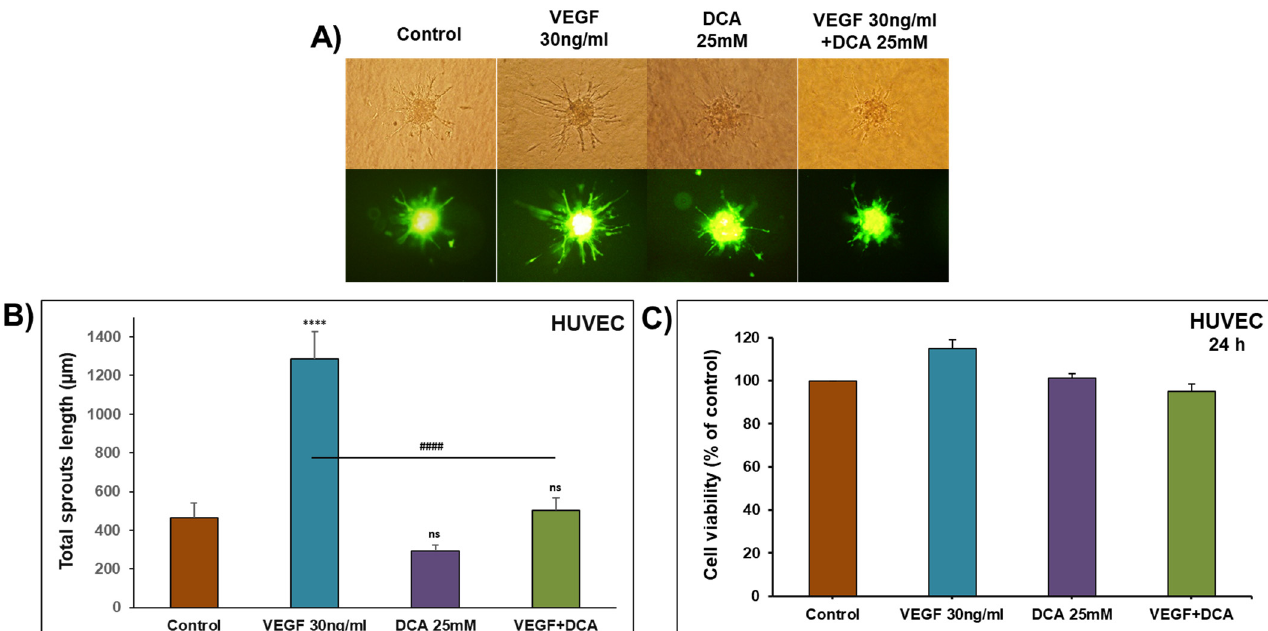
Figure 6. Effect of DCA on the formation of sprouts by the embedded HUVECs spheroids in vitro. ( A ) Representative images of pre-dyed HUVEC spheroids after 24 h of embedding in collagen matrix in the presence of VEGF 30 ng/mL, DCA 25 mM or VEGF + DCA. An inverted microscope at 20× magnification was used. ( B ) Average of total sprout lengths from different spheroids per condition from one representative experiment. ( C ) HUVECs’ viability was determined as described in the Material and Methods. Experiments were repeated 2 times. Columns represent means of 12 spheroids; bars represent S.E.M. **** Significantly different at <0.0001. #### Significantly different at <0.0001. ns: non-significant.